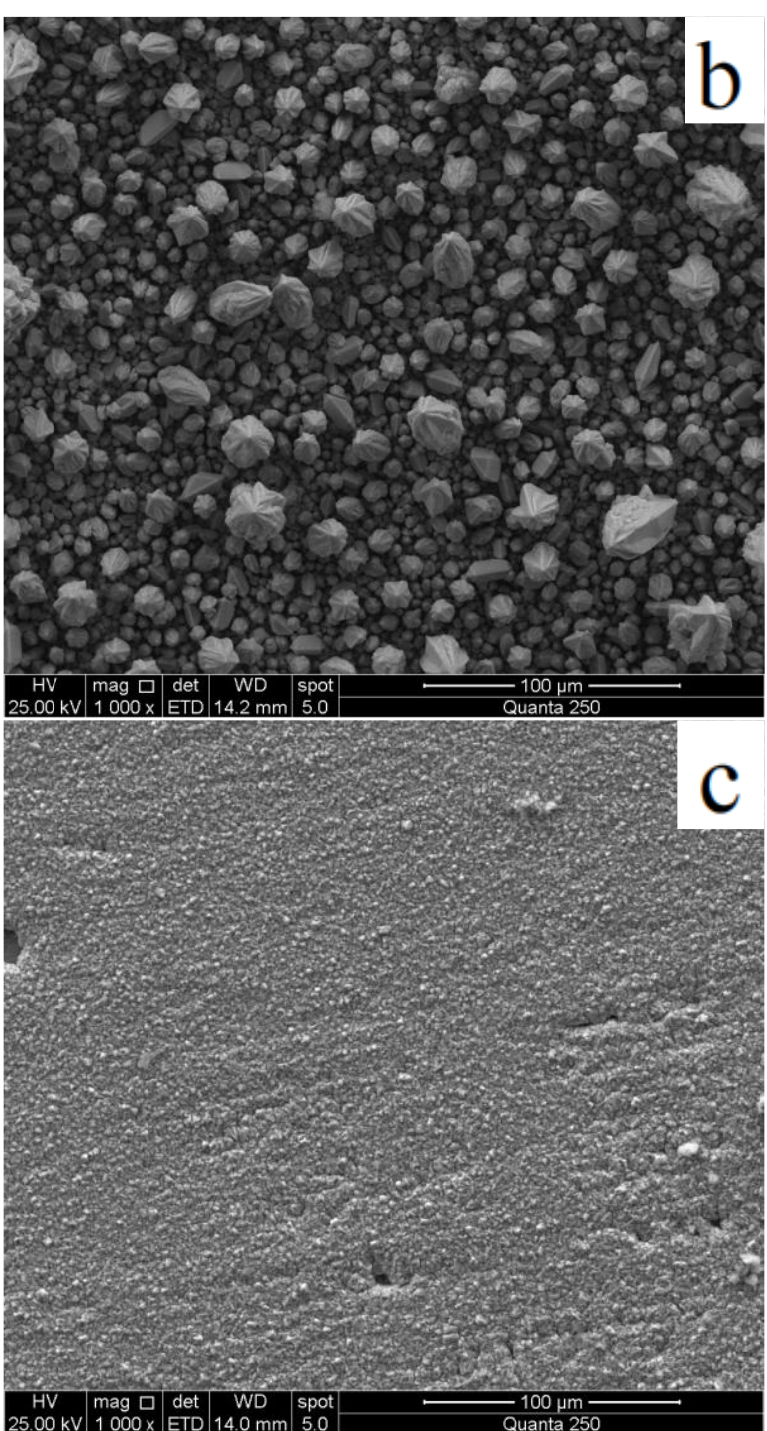
Figure 8. SEM scan comparison of plated surface under bidirectional pulse and DC electroplating.